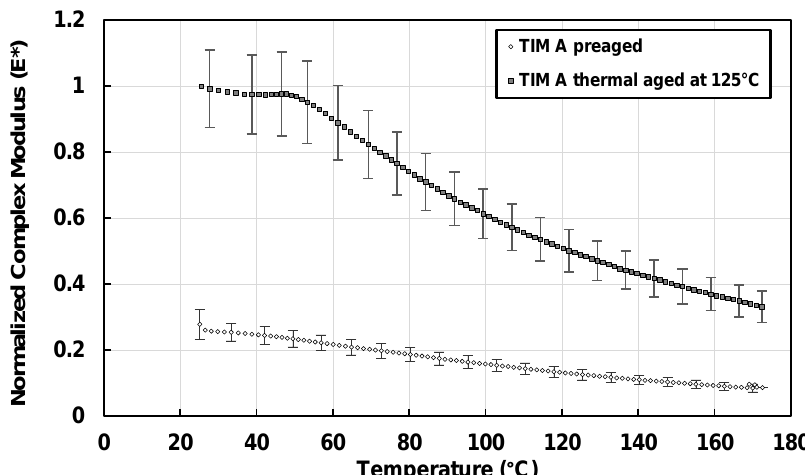
Figure 8. Complex modulus of TIM A.